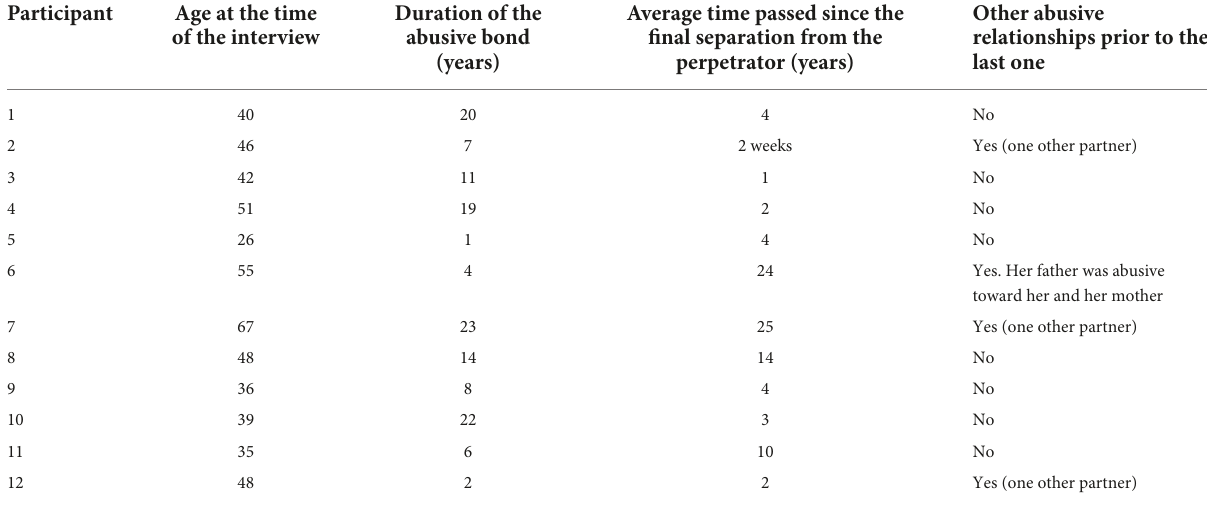
TABLE 1 Characteristics of the stage I sample (DVA